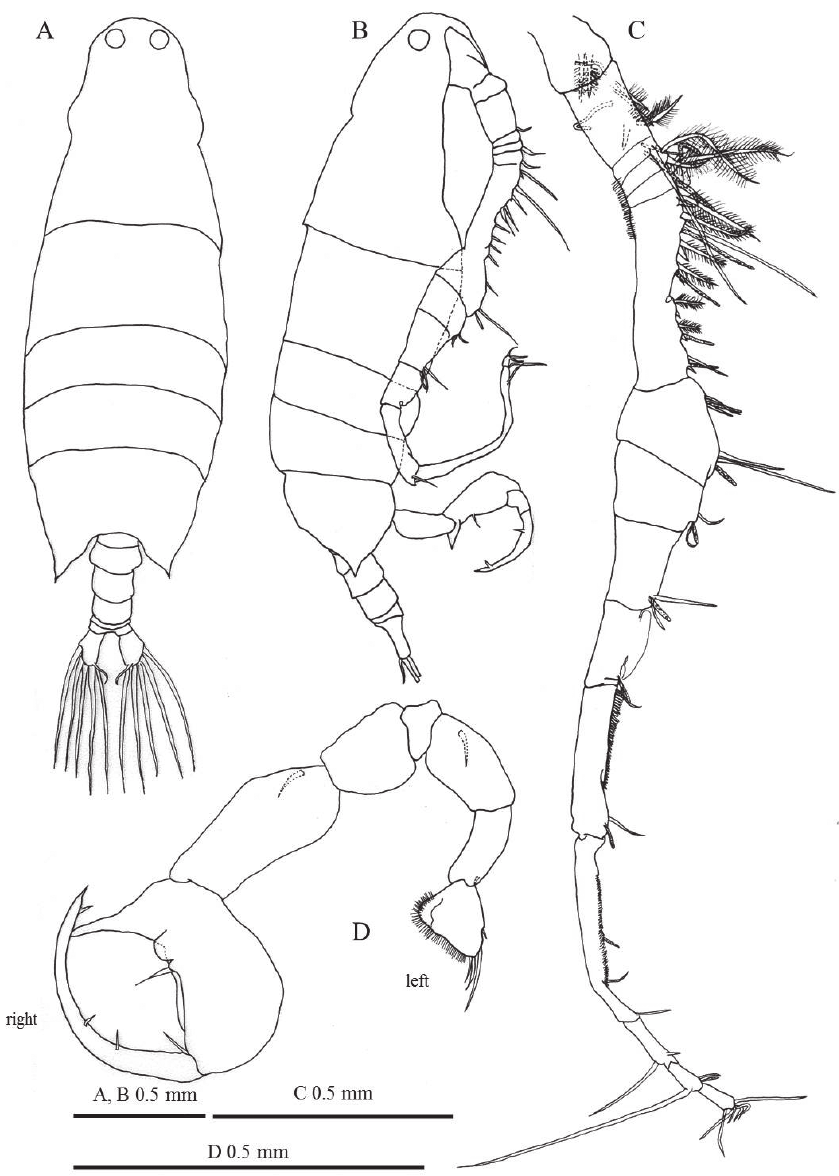
Figure 4. Labidocera churaumi sp. n., male (Paratype). A habitus, dorsal view B habitus, lateral view C right antennule D leg